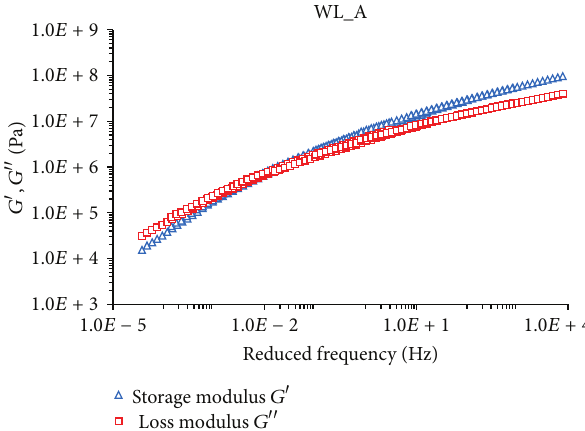
Figure 7: Storage and loss moduli versus frequency (sample WL